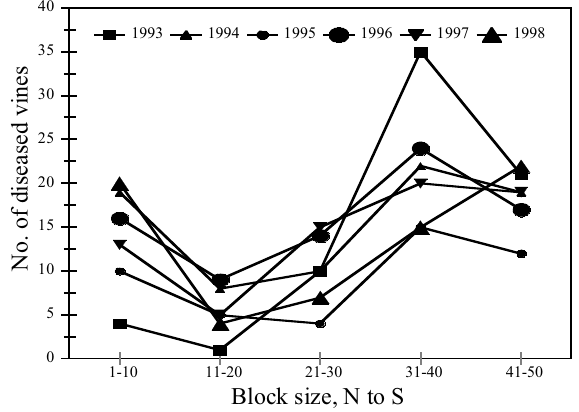
shown.Fig. 9. Number of diseased vines per block of ten rows (10 plants per row) in a vineyard at Gambassi Terme from 1993 to